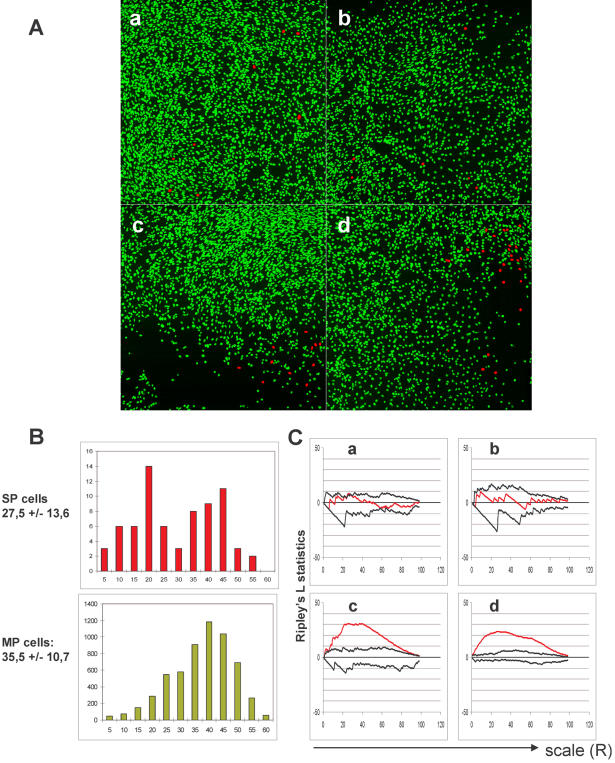
Localization of the SP cells in the growing population of C2C12 cells.
A: The SP cells were identified on the basis of their capacity to exclude the fluorescent dye Hoechst 33342. Four representative images (a, b, c and d) are shown from regions with different cell densities. The nuclei are shown in false color (red for SP cells and green for MP cells). B: The frequency distribution of the number of neighbours is significantly different for SP and MP cells (upper and lower panel). The average number of neighbours is shown on the left side of each panel. Note the bimodal distribution for SP cells. The number of neighbours for each cell in a circle of R = 15 µm was calculated on the basis of the digitalized images. The two distributions were found to be significantly different (p<0.001) as analysed by the non-parametric Wilcoxon-Rank-Sum test. C: Analysis of the spatial randomness of SP cell distribution using Ripley's L statistics of the four images shown in Fig. 5A. The red lines indicate the L-functions for the SP cells over a range of r = 100. The black lines show the upper and lower limits of the envelope functions for the images analysed. The c and d patterns are significantly different from a random pattern, because the values of the observed L-function are larger than the upper envelope function while the two other L-functions (panels a and b) indicate homogeneously distributed SP cells on the corresponding images.